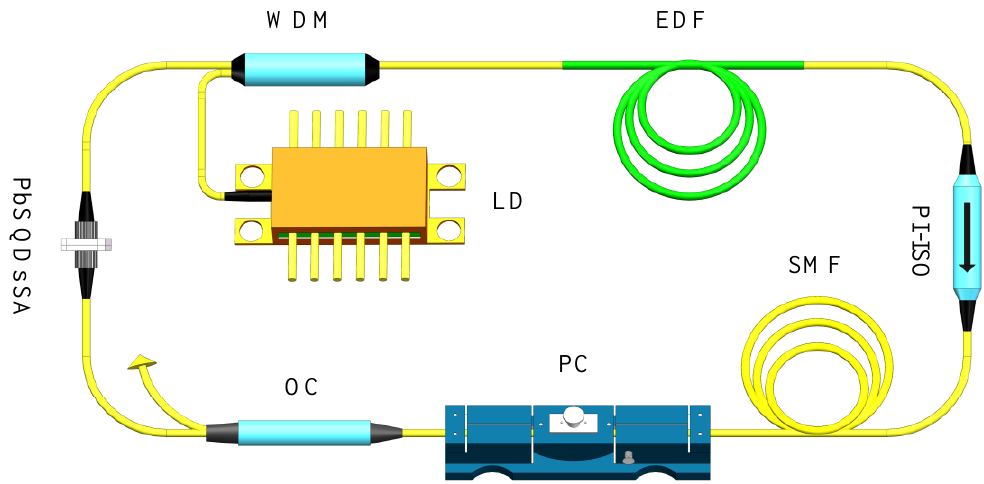
Figure 3. Laser setup. Laser diode (LD), wavelength division multiplexing (WDM), erbium-doped fiber (EDF), polarization- insensitive isolator (PI-ISO), single-mode fiber (SMF), polarization controller (PC), output coupler (OC), and Lead sulfide quantum dots saturable absorber (PbS QDs SA).